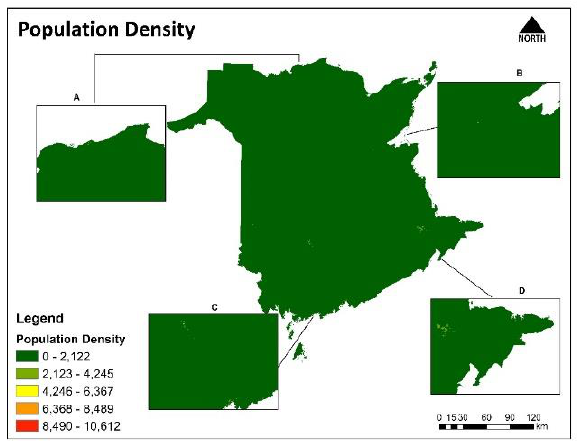
Figure A14. Population Density (km 2 ).